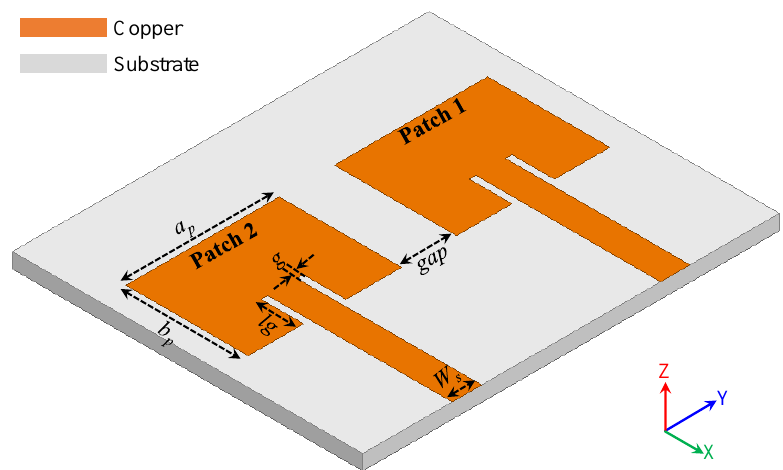
Figure 1. Geometry of the initially designed MIMO antenna ( a p = 16.8, b p = 12.91, gap = 5.82, W s = 3.1, g = 0.7, and lg = 4.5 [unit = mm]).